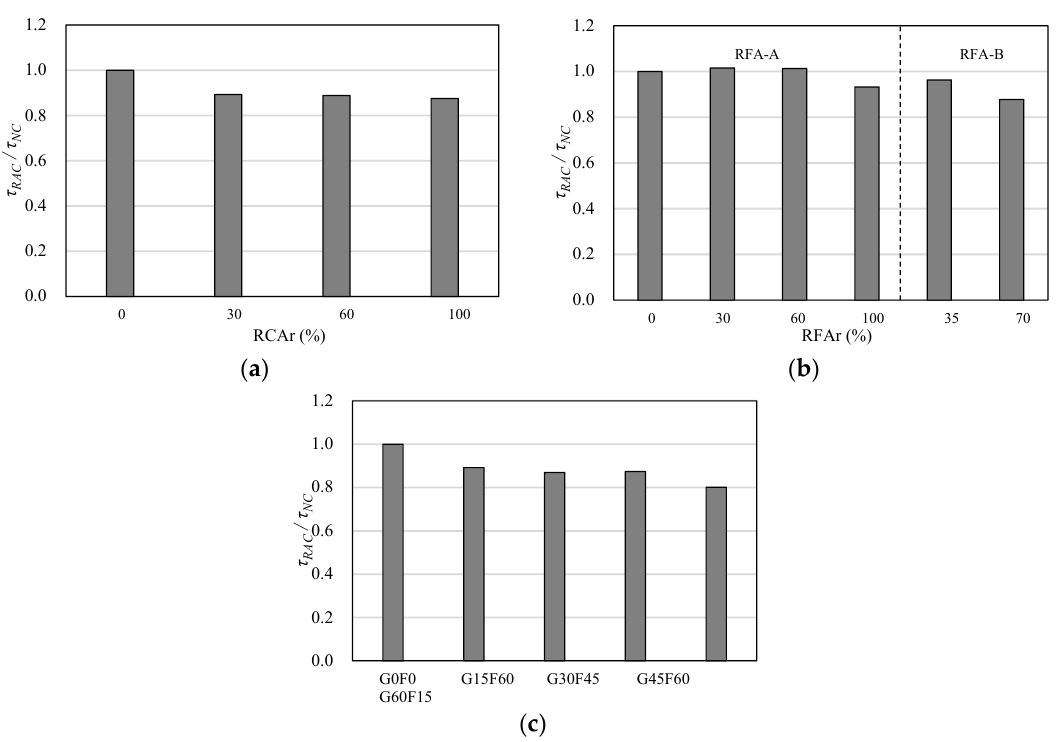
Figure 6. Comparison of bond strength ratio for pull-out test specimens. ( a ) RCA [23]; ( b ) RFA [29]; ( c ) RFCA.